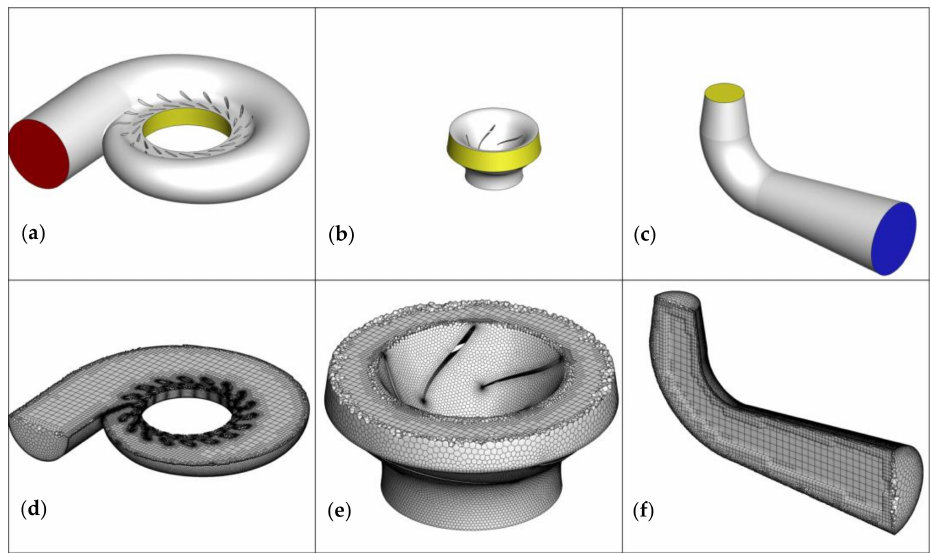
Figure 6. Top row: the regions of the computational domain, ( a , d ) the spiral casing, ( b , e ) the rotor, ( c , f ) the draft tube. Bottom row: details of the computational mesh. All images correspond to configurations for the sliding mesh